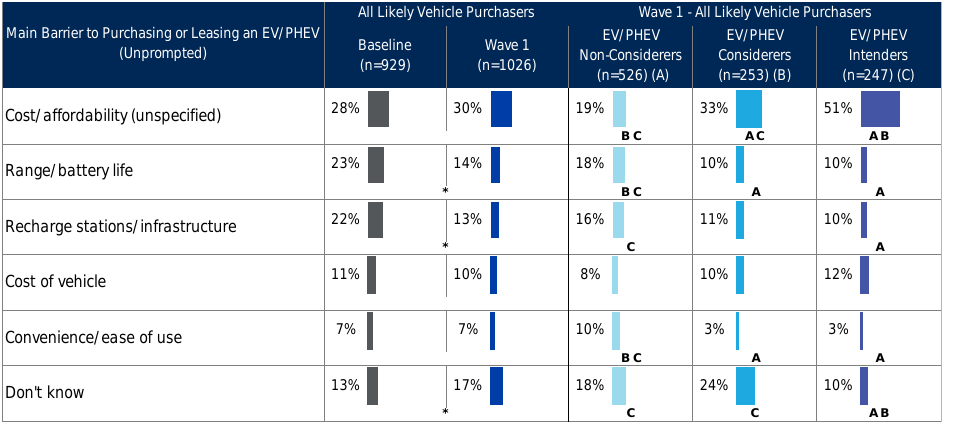
Figure 4. Unprompted barriers mentioned to purchasing or leasing an EV, by survey wave and segment (multiple responses allowed). Note: Only the top five items mentioned displayed in figure. Letters A–C indicate statistically significant differences between likely vehicle purchaser segments (z-test for proportions, p < 0.05). * Indicates a statistically significant difference between Baseline and Wave 1 survey’s all likely vehicle purchasers (z-test for proportions, p < 0.05).